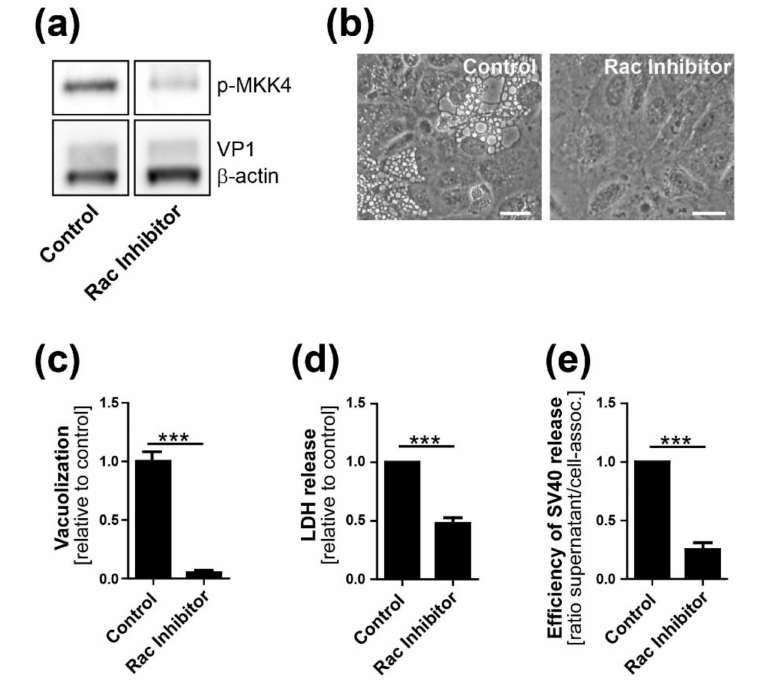
Figure 8. Rac1 activity is required for e ffi cient SV40-induced vacuole formation, cell lysis, and virus release. CV-1 cells were infected with SV40 at at MOI of 10. At 12 h.p.i., the Rac1 inhibitor EHT1864 was added and cells were analyzed at 48 h.p.i. ( a ) Western blot analysis of MKK4 phosphorylation